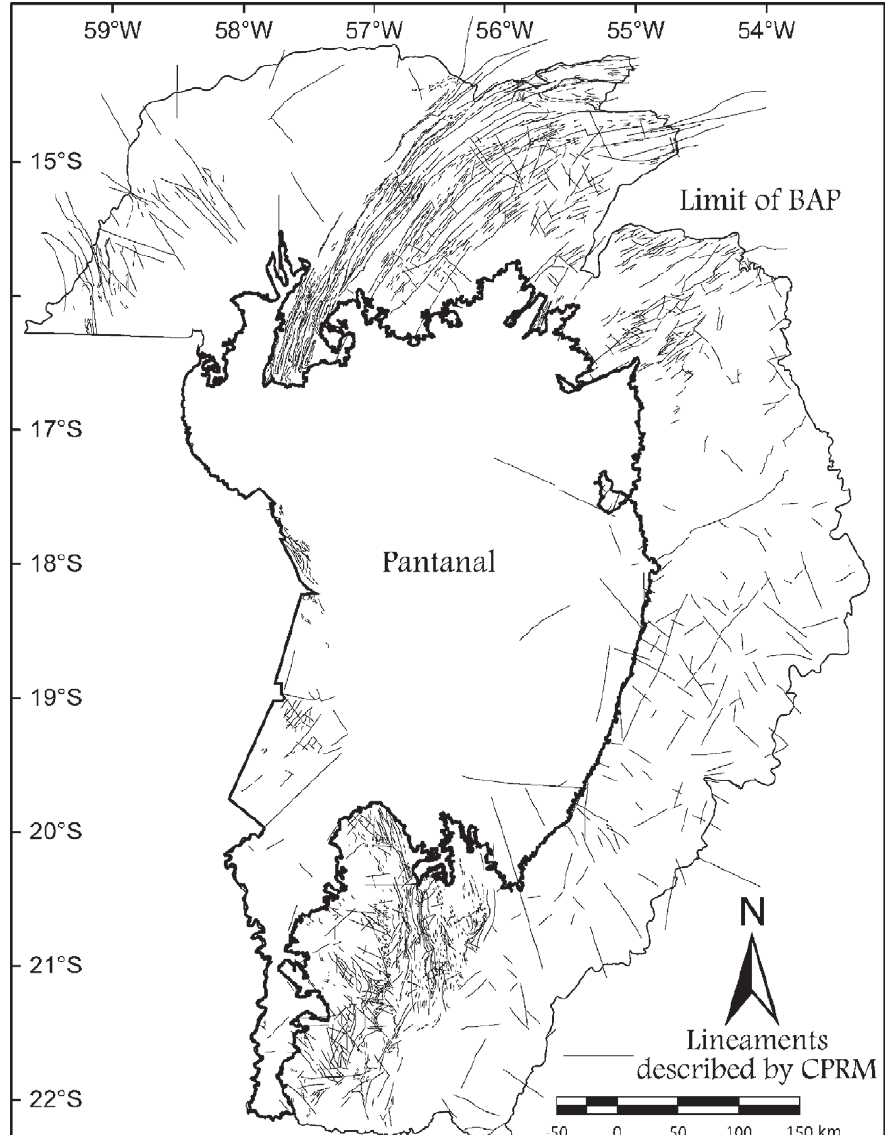
Figure 2 - Map of regional lineaments surrounding the Pantanal (structural data from CPRM – Schobbenhaus and Bellizzia 2001). The Upper Paraguay basin and Pantanal limits are from PROBIO (Silva and Abdon